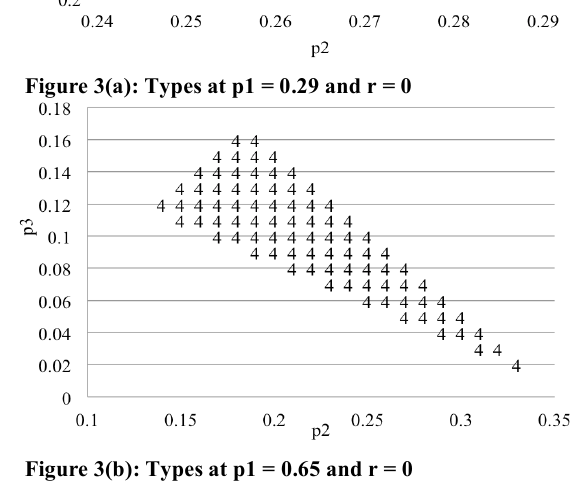
Figure 3(a): Types at p1 = 0.29 and r = 0